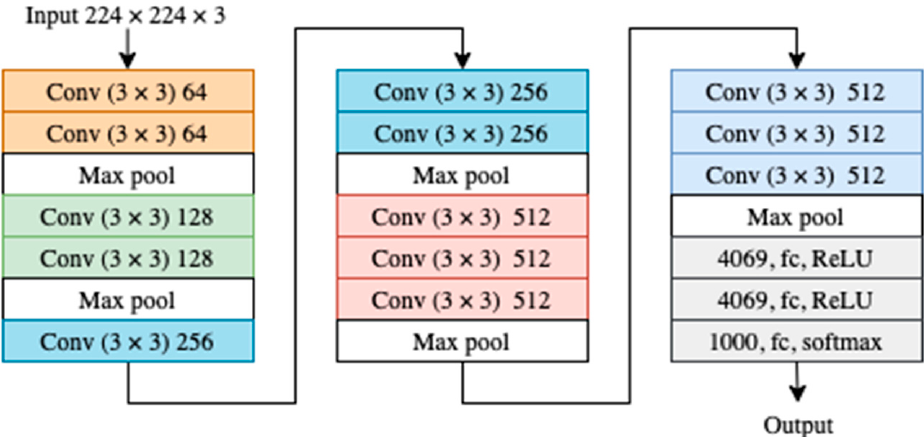
Figure 1. VGG16 architecture where each color represents a block of layers with the same kernel